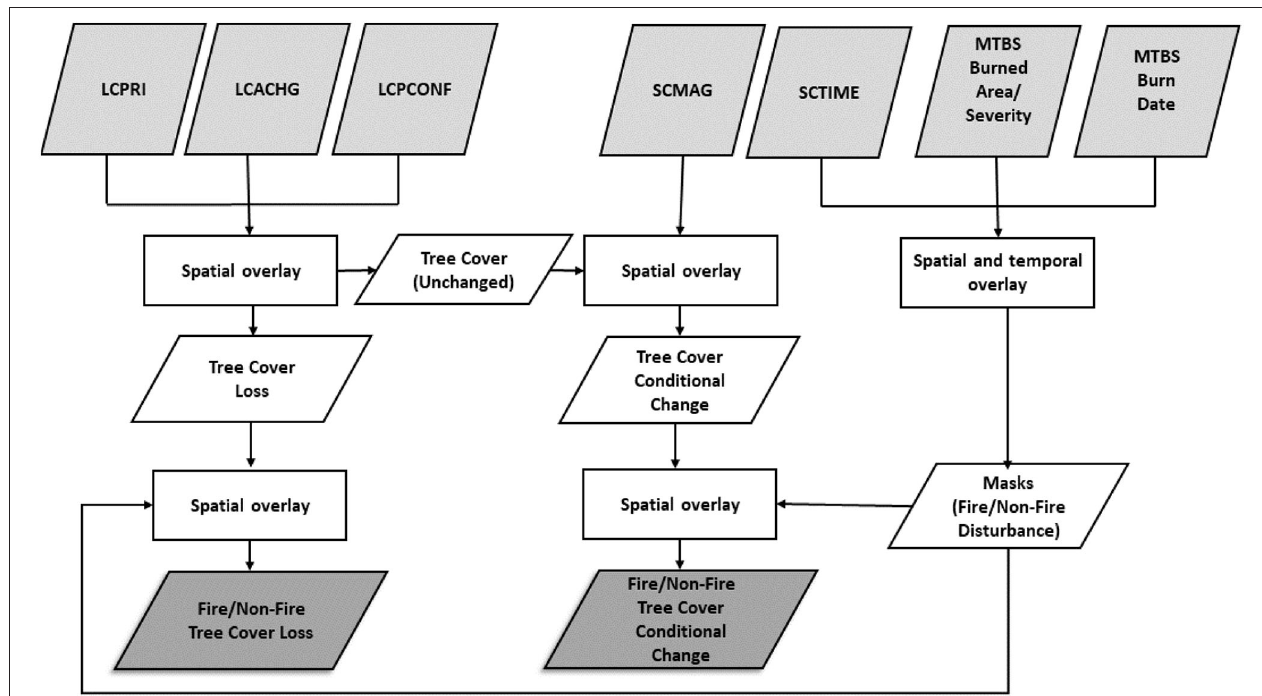
FIGURE 2 | A flowchart of methods to generate fire-induced and non-fire related tree cover loss and tree cover conditional change from LCMAP annual land-cover and land-surface change products and Monitoring Trends in Burn Severity (MTBS) wildfire datasets. LCPRI, primary land cover; LCACHG, land cover change; LCPCONF, primary land cover confidence; SCTIME, time of spectral change; SCMAG, change